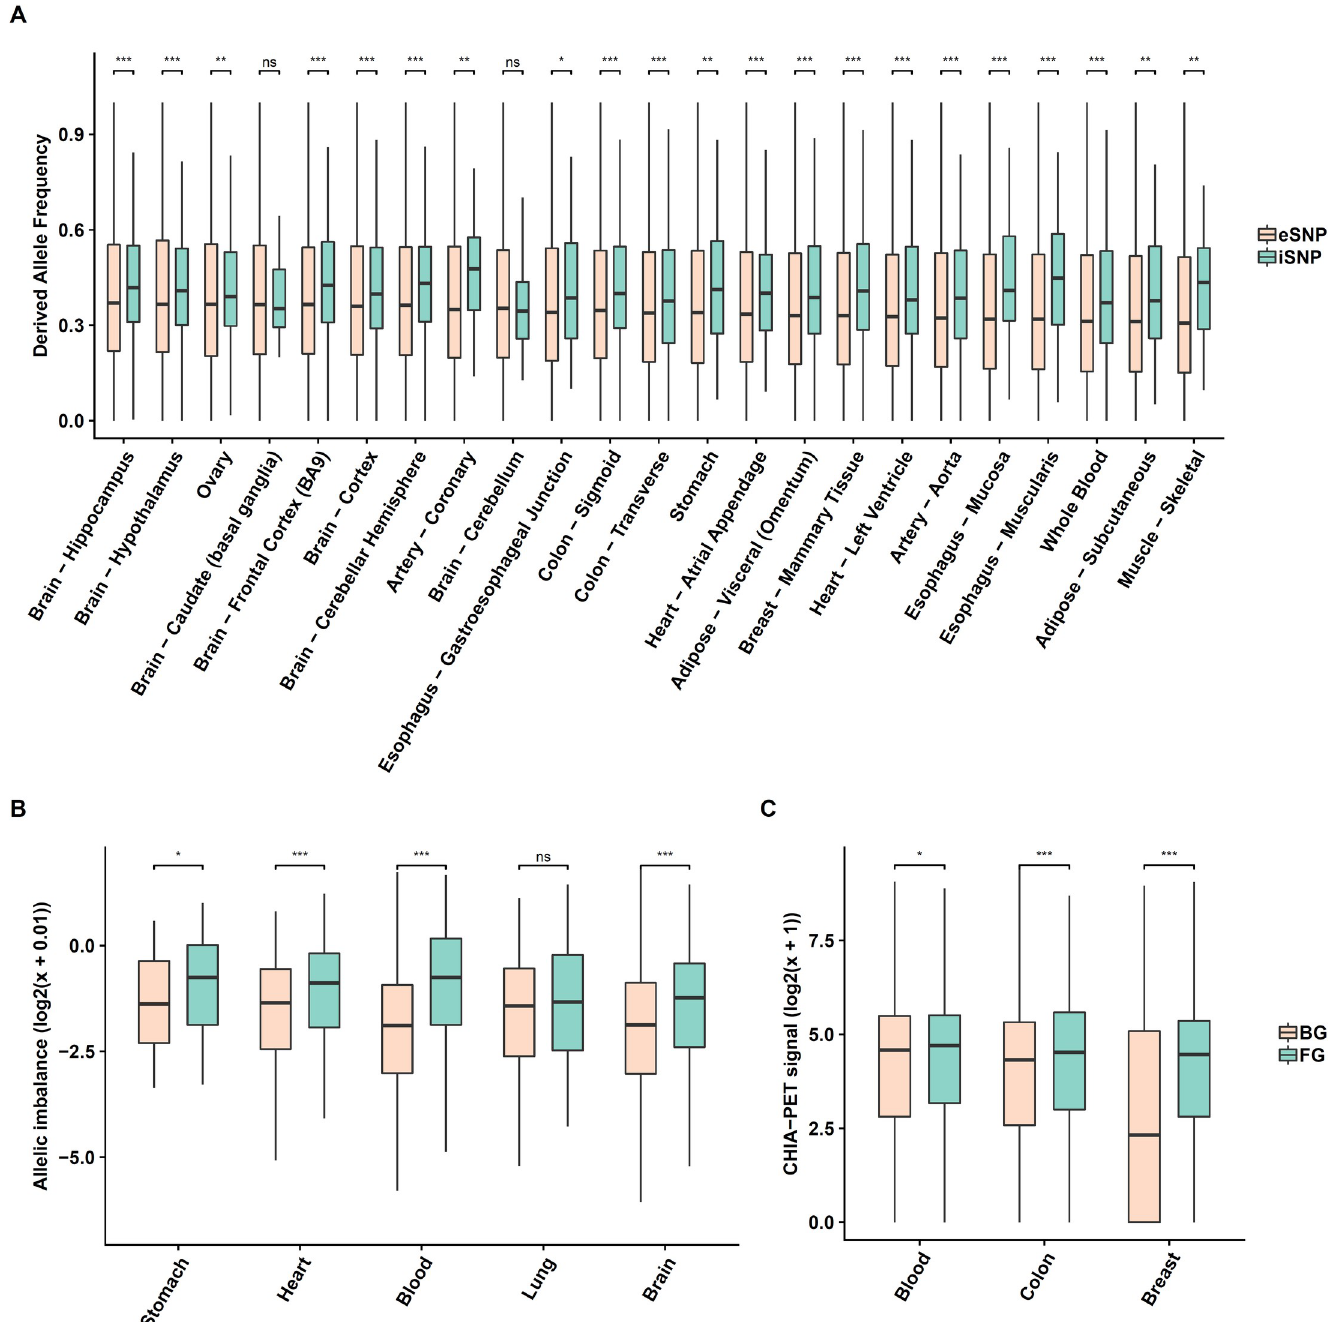
Fig 5. Detected SNPs exhibit allelic imbalance for open chromatin states, spatial proximity to target genes and higher derived allele frequency. (A) Detected SNPs (green) exhibit significantly higher derived allele frequency compared to eSNPs (pink) across 21 tissues out of 23. (B) Detected SNPs exhibit significant allelic imbalance for open chromatin states. The foreground is the imbalance distribution of detected SNPs (green), the control is the imbalance distribution generated from a null binomial model (pink; see Methods). (C) Detected SNP-Gene pairs exhibit spatial proximity quantified by ChIA-PET data (pooled cell lines K562, Hela, Nb4, and MCF7). The foreground is detected SNP-Gene pairs (green) and the control is random SNP-gene pairs within 1M bps, controlled to match the distance distribution of the foreground (pink). The y-axis is the enrichment scores.